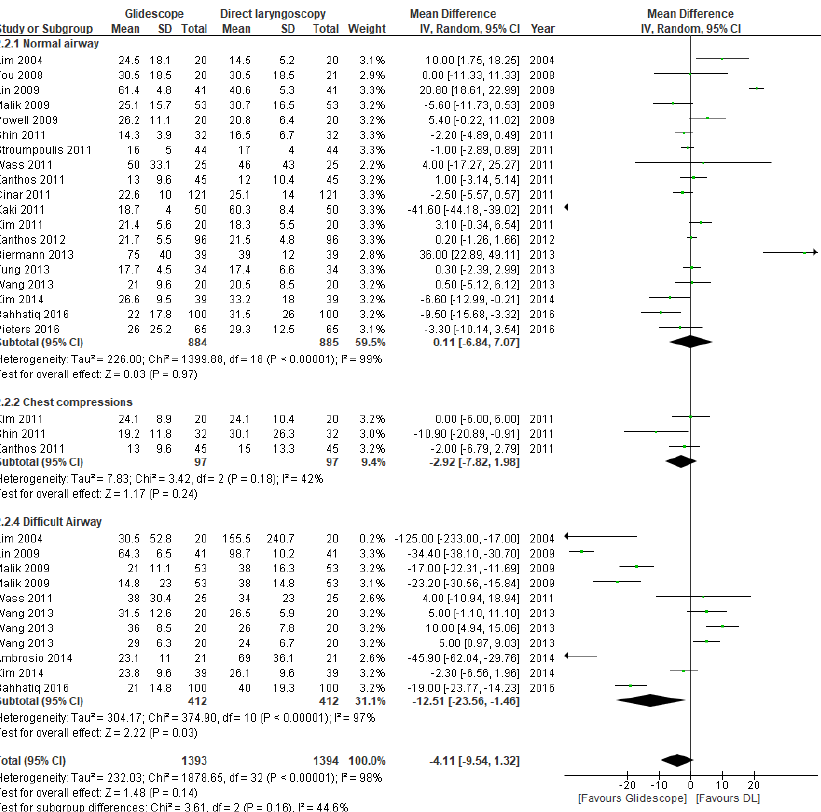
Figure 8. Mean difference (MD) in time to intubation (in seconds) in manikin trials comparing Glidescope ® videolaryngoscope to direct laryngoscopy. The pooled estimate (rhombus) was derived using the DerSimonian and Laird random effects method. The squares depict an individual study point estimate of the mean difference. Solid horizontal lines display the 95% CI of the point estimate. The vertical line represents an MD of o, indicating no difference between Glidescope ® videolaryngoscopy and direct laryngoscopy. (DL = direct laryngoscopy). Ambrosio, 2014 [32]; Bahhatiq, 2016 [34]; Biermann, 2013 [29]; Cinar, 2011 [21]; Kaki, 2011 [22]; Kim, 2011 [23]; Kim, 2014 [33]; Lim, 2004 [16]; Lin, 2009 [17]; Malik, 2009 [18]; Pieters, 2016 [35]; Powell, 2009 [19]; Shin, 2011 [25]; Stroumpoulis, 2011 [26]; Tung, 2013 [30]; Wang, 2013 [31]; Wass, 2011 [24]; Xanthos, 2011 [27]; Xanthos, 2012 [28]; You, 2009